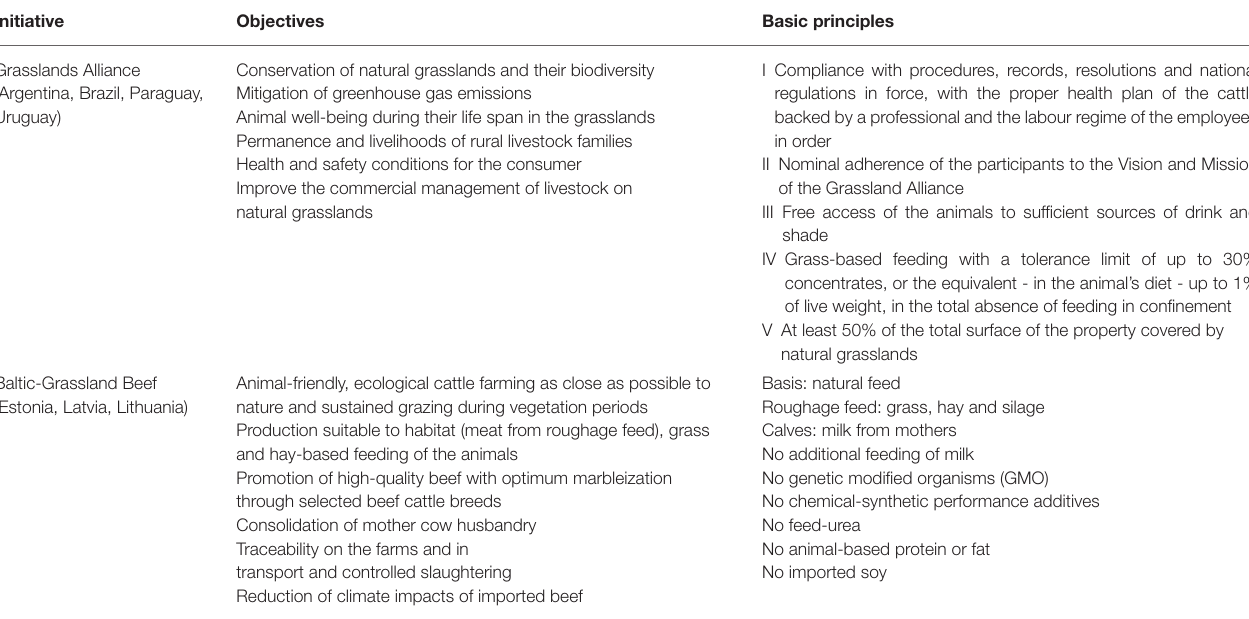
TABLE 2 | Examples of grassland beef value chains in South America and Europe, outlining their objectives and basic principles. Initiative Objectives Basic